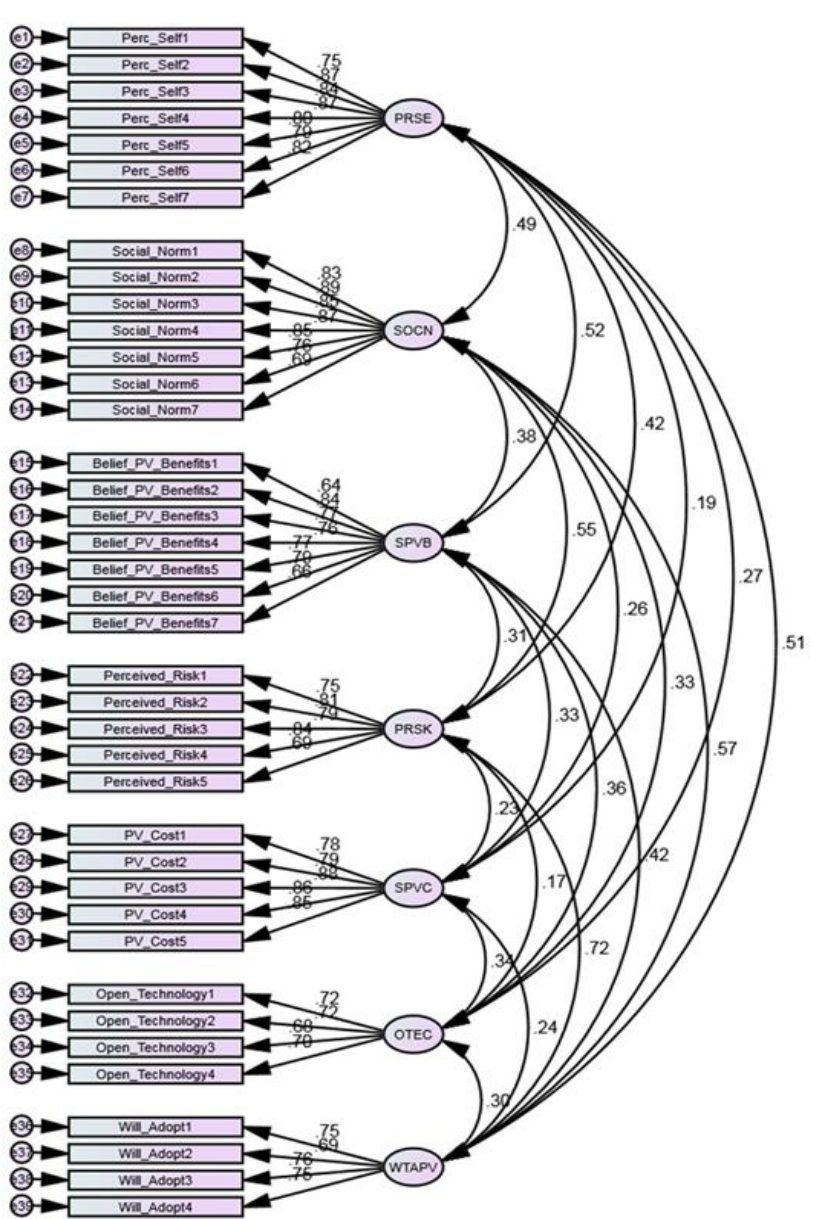
Figure 2. Confirmatory factor analysis, representing that all items substantially loaded on the respective constructs.